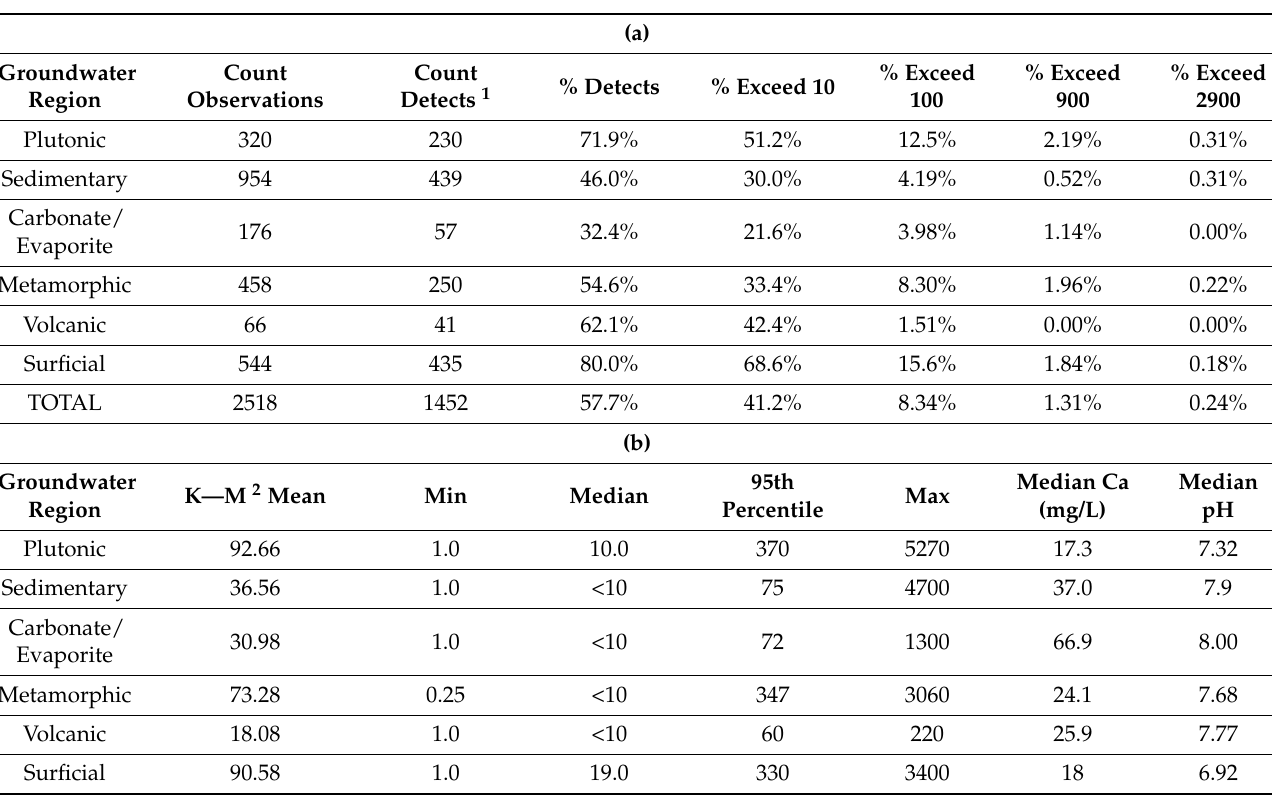
Table 1. For each groundwater region, ( a ) the percentage of Al samples exceeding various thresholds and ( b ) statistical summaries of Al concentrations with median calcium and pH shown for comparison.